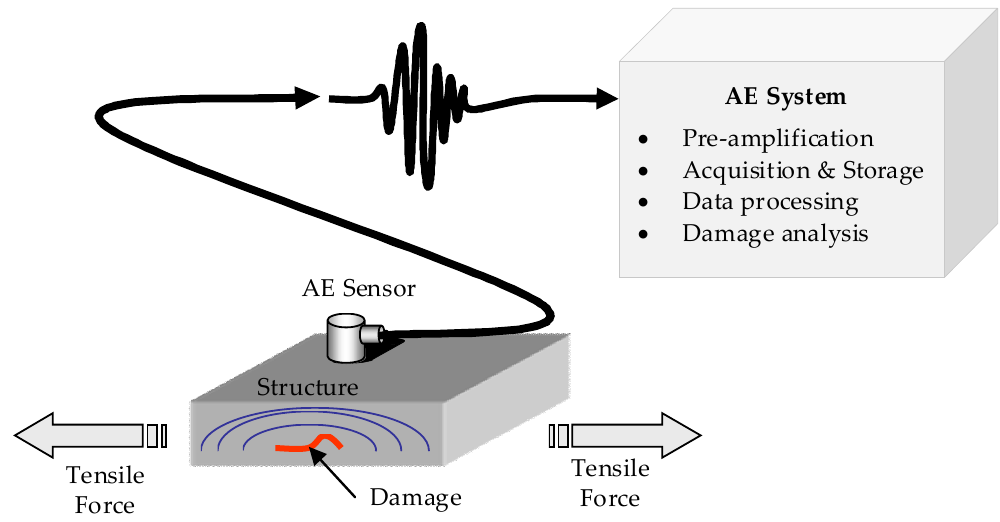
Figure 1. The structure diagram of AE detection theory.